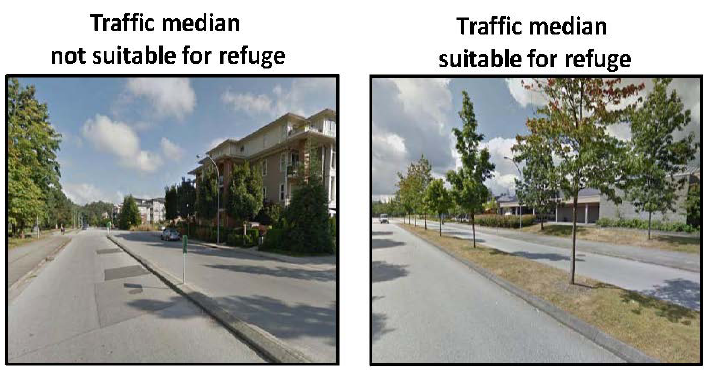
Figure 2. Google Street View images of traffic medians.